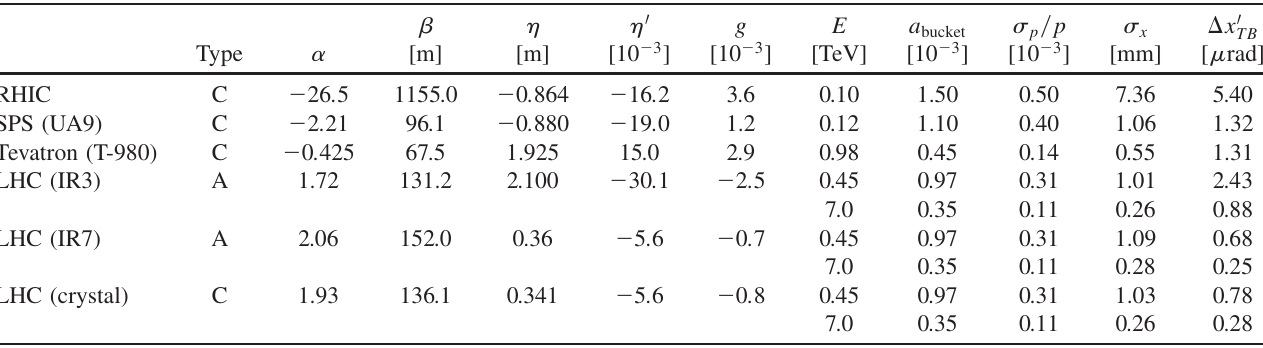
TABLE I. Nominal optics, grazing functions, and other values at primary collimators in four accelerators. The collimator type is recorded as either ‘‘A’’ for amorphous or ‘‘C’’ for crystal. Note that the LHC IR7 location (for betatron cleaning) is almost identical to the tentatively proposed LHC crystal location. The last column records the grazing angle spread across the rf bucket.